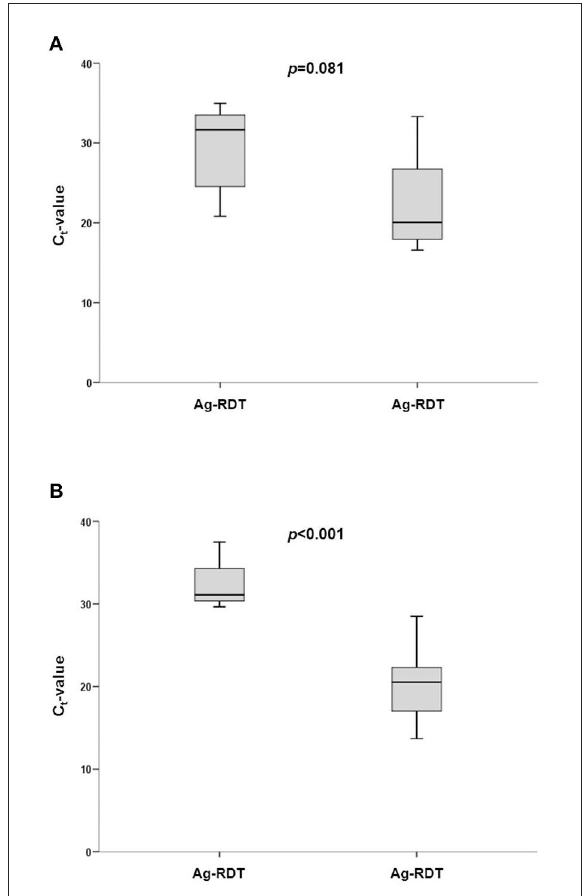
FIGURE2 Cycle threshold (C t )-values observed for SARS-CoV-2 determination by qRT-PCR according to agreement with BD Veritor System for Rapid Detection of SARS-CoV-2 (Veritor) in (A) asymptomatic and (B) symptomatic